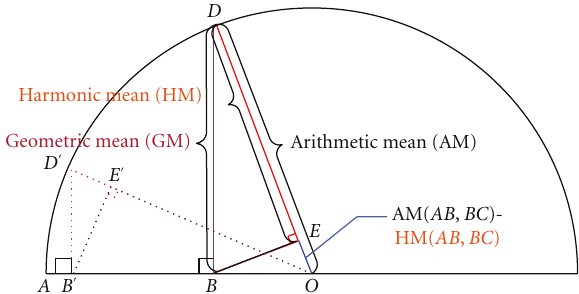
Figure 7: Geometrical interpretation of the harmonic mean, the arithmetic mean, and the geometric mean of AB ( AB (cid:8) ) and BC ( B (cid:8) C